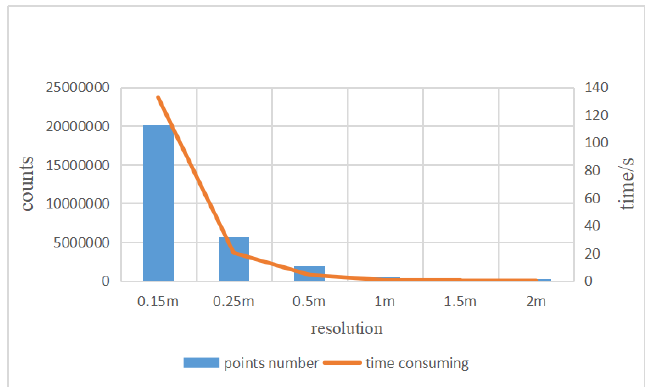
Figure 20. Time consumption for point cloud classification under different point